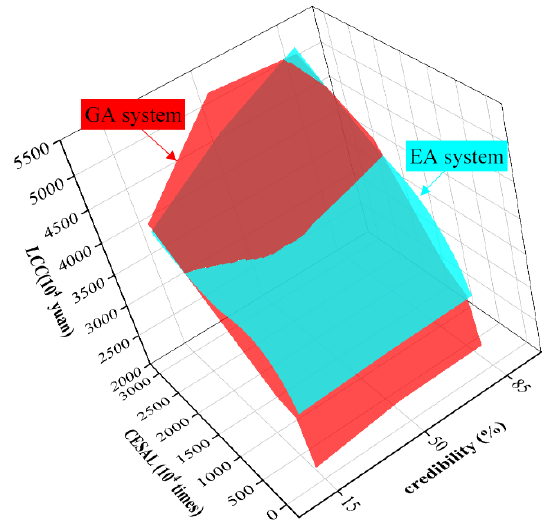
Figure 6. The LCC of the EA system and the GA system under representative traffic conditions and different credibility: CESAL = cumulative equivalent single axle loads; LCC u = user cost.